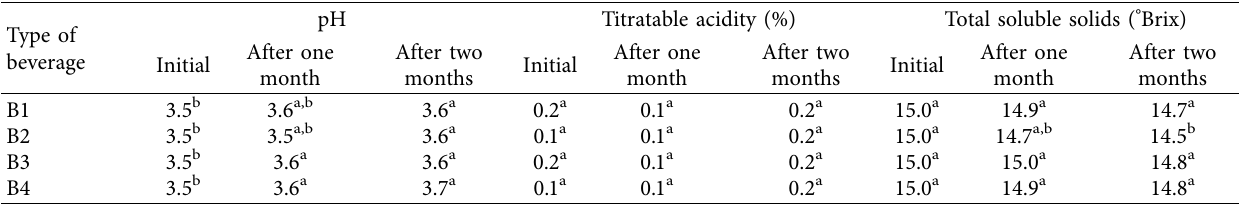
Figure 5: Average scores of regular nonfortified pineapple RTS beverage (T1) and pineapple RTS incorporated with encapsulated folic acid (T2) for sensory attributes. Table 2: Physicochemical properties of beverages over two